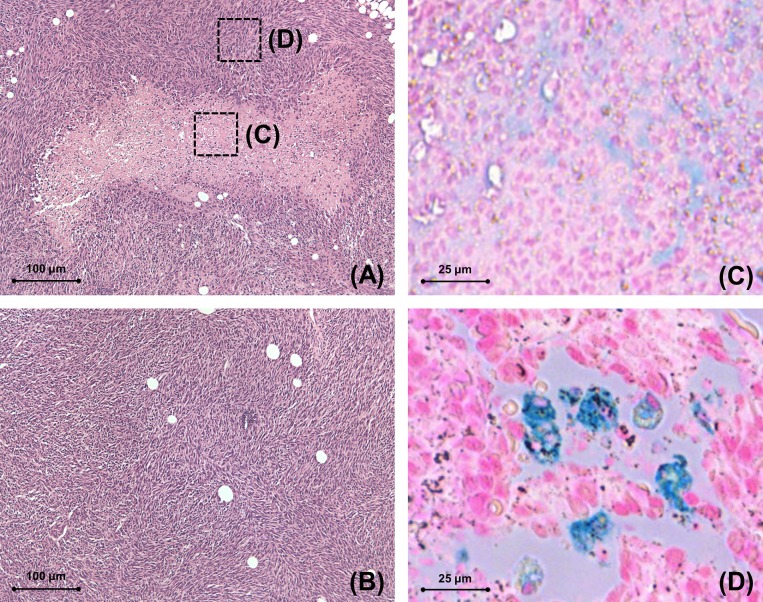
4T1 tumor T1-enhancement corresponds to clusters of free iron oxides in central necrosis.(A) H&E stain of 4T1 tumor shows a necrotic core (square C) and highly cellular tumor periphery (square D, 100x magnification). (B) H&E stain of PymT tumor shows uniformly heterogeneous tumor tissue without central necrosis (100x magnifications). (C) Prussian blue stain (400x magnification) of the necrotic core of the 4T1 tumor shows diffuse distribution blue (iron) staining consistent with iron oxide nanoparticles in a non-compartmentalized, extracellular localization. (D) Prussian blue stain (400x magnifications) of the peripheral area of the 4T1 tumor shows blue iron staining in cells.